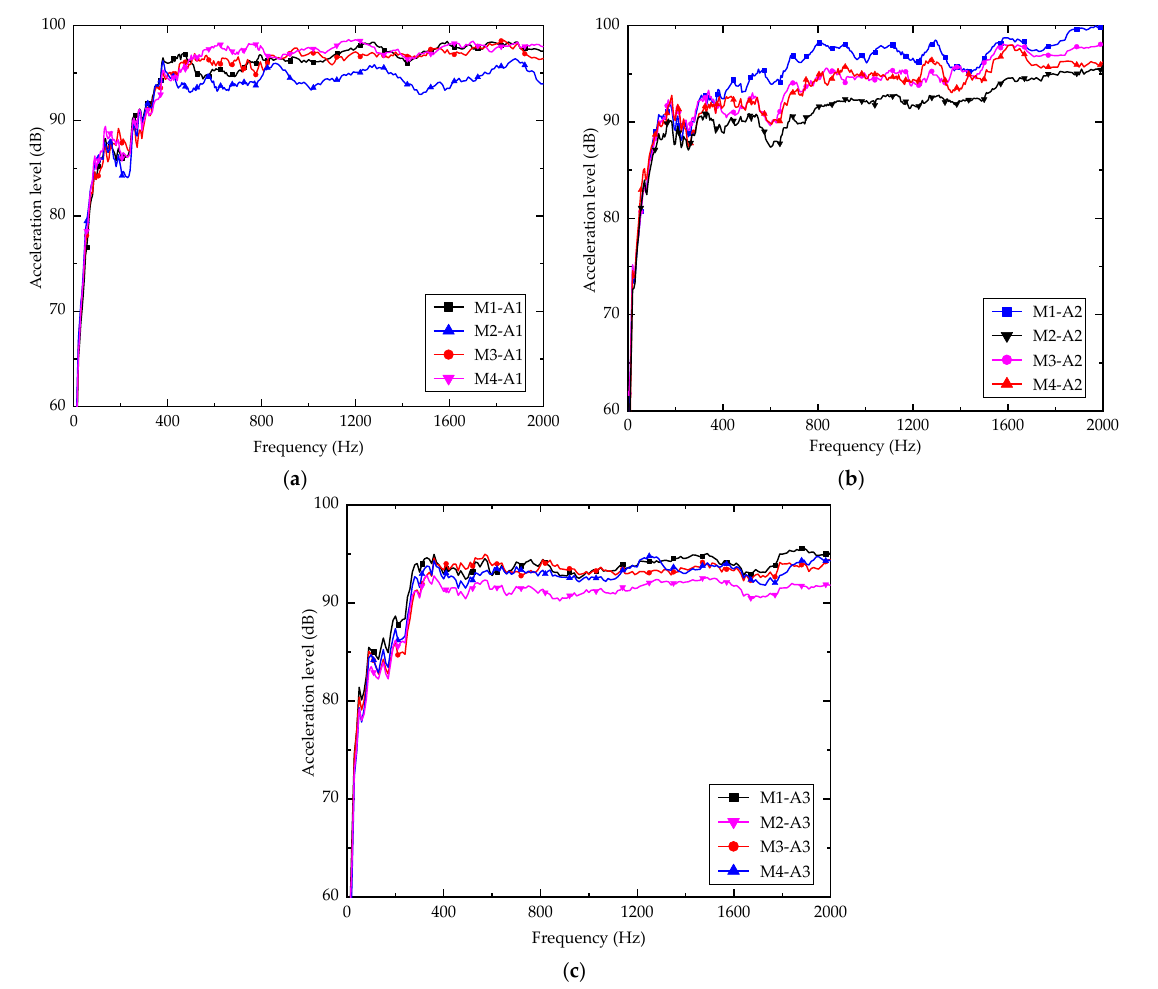
Figure 10. Comparison of vibration acceleration levels at different measuring points. ( a ) Measuring point A1; ( b ) measuring point A2; ( c ) measuring point A3.